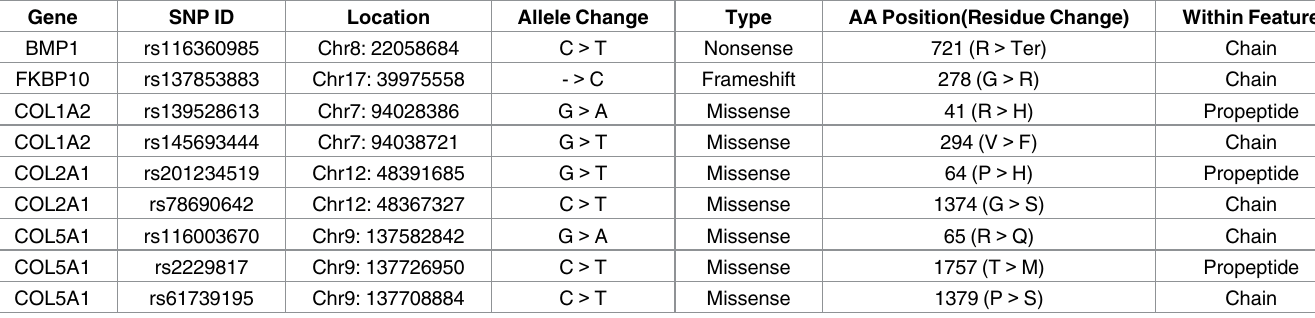
Table 3. Variants identified in genes involved in ECM composition and synthesis.